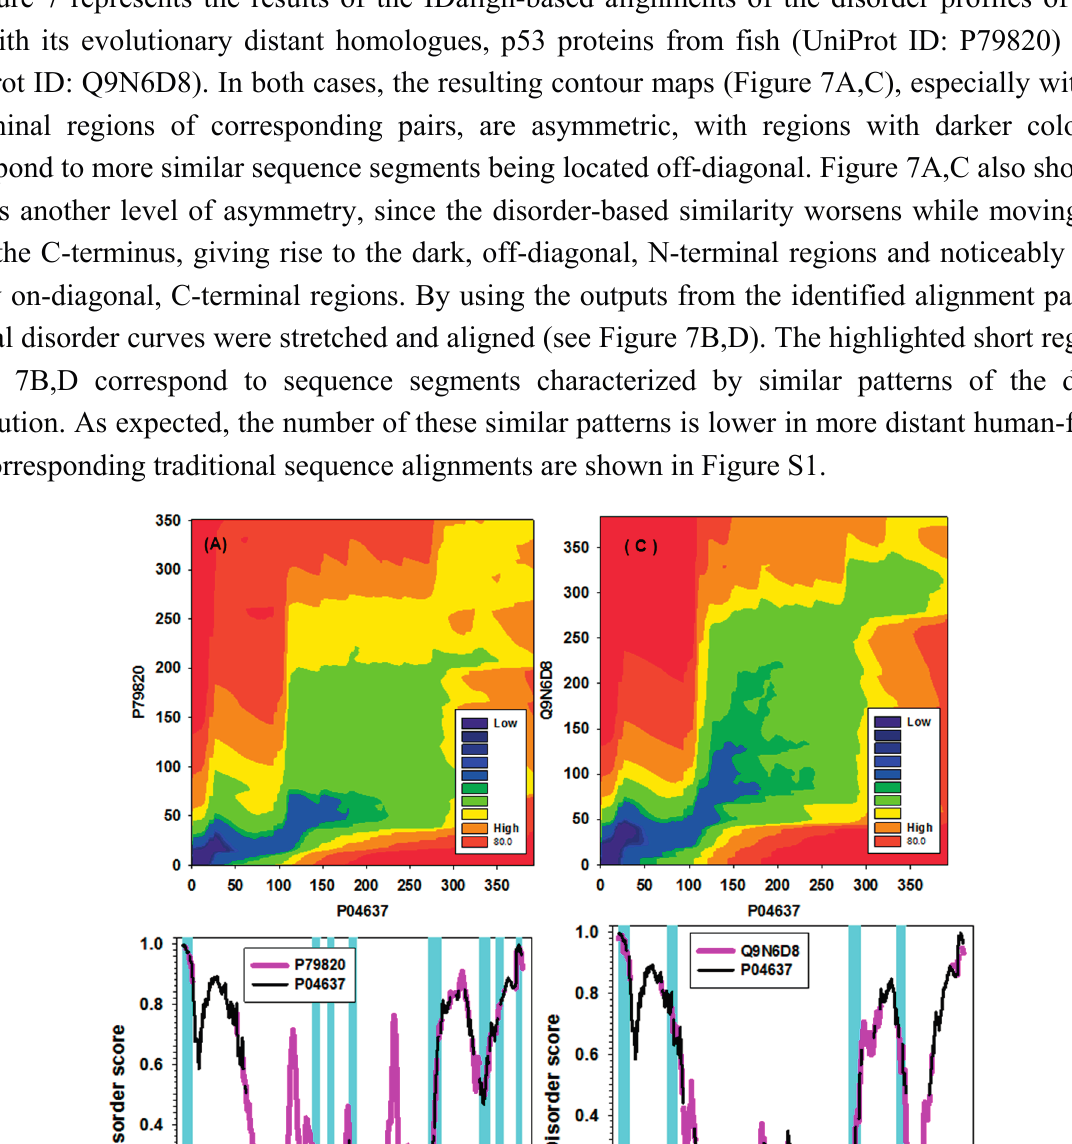
Figure 7. Identified alignment paths and alignments for sequence pairs between human p53 (Uniprot ID: P04637) and fish p53 (Uniprot ID: P79820) in ( A , B ), and between human p53 and fly p53 (Uniprot ID: Q9N6D8) in ( C , D ), respectively. ( A , C ) Alignment paths (contour maps) between two sequences in each of the sequence pairs were identified using our newly developed package; ( B , D ) Alignment of disorder curves along the alignment paths for two sequence pairs: P79820 (pink) and P04637 (black) in ( B ); Q9N6D8 (pink) and P04637 (black) in ( D ). Only overlapped segments of which the distance less than 0.05 were highlighted by